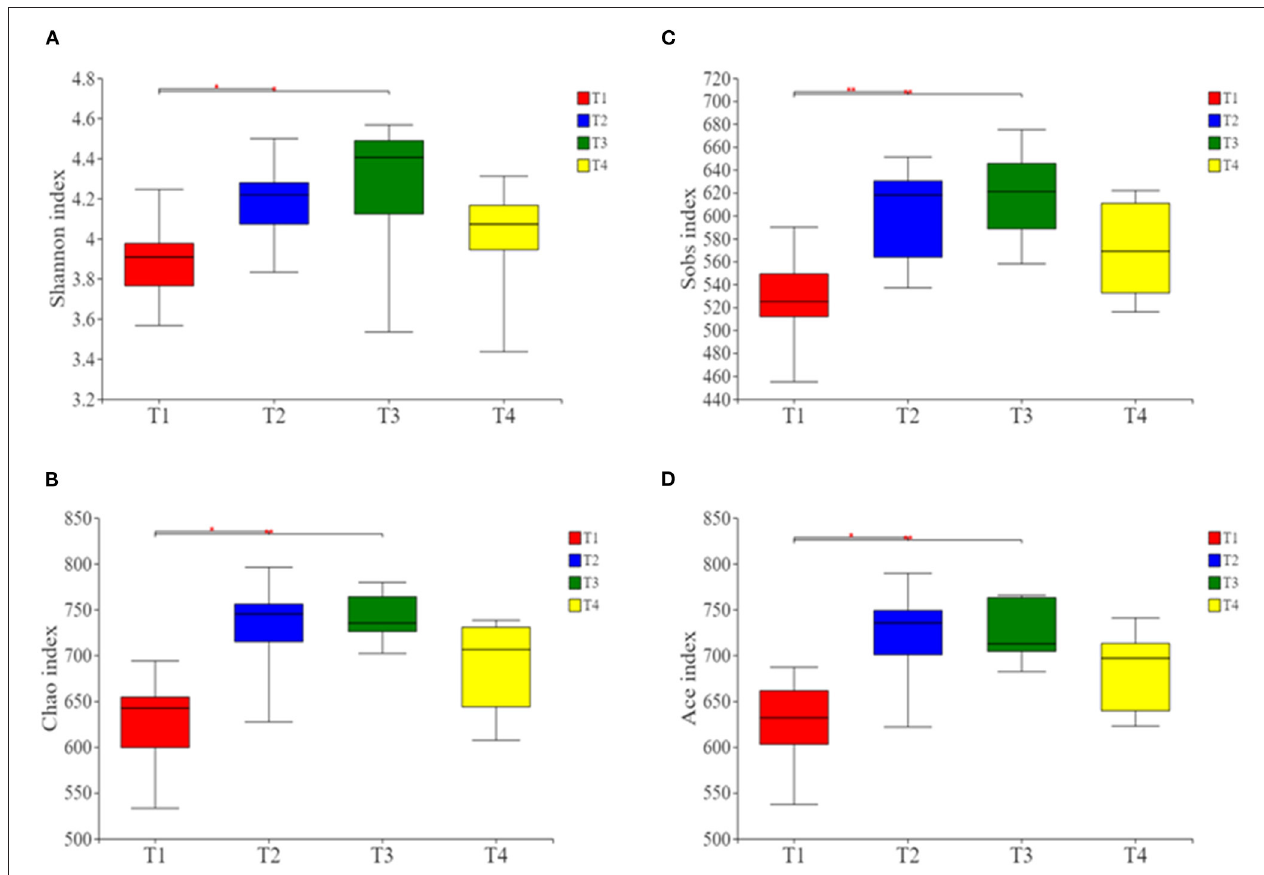
FIGURE 2 | Alpha-diversity analysis of gut microbial community structure in each group. (A) Shannon index. (B) Chao index. (C) Sobs index. (D) Ace index. Red represents the T1 group, blue represents the T2 group, green represents the T3 group and yellow represents the T4 group. * p < 0.05, and ** p <